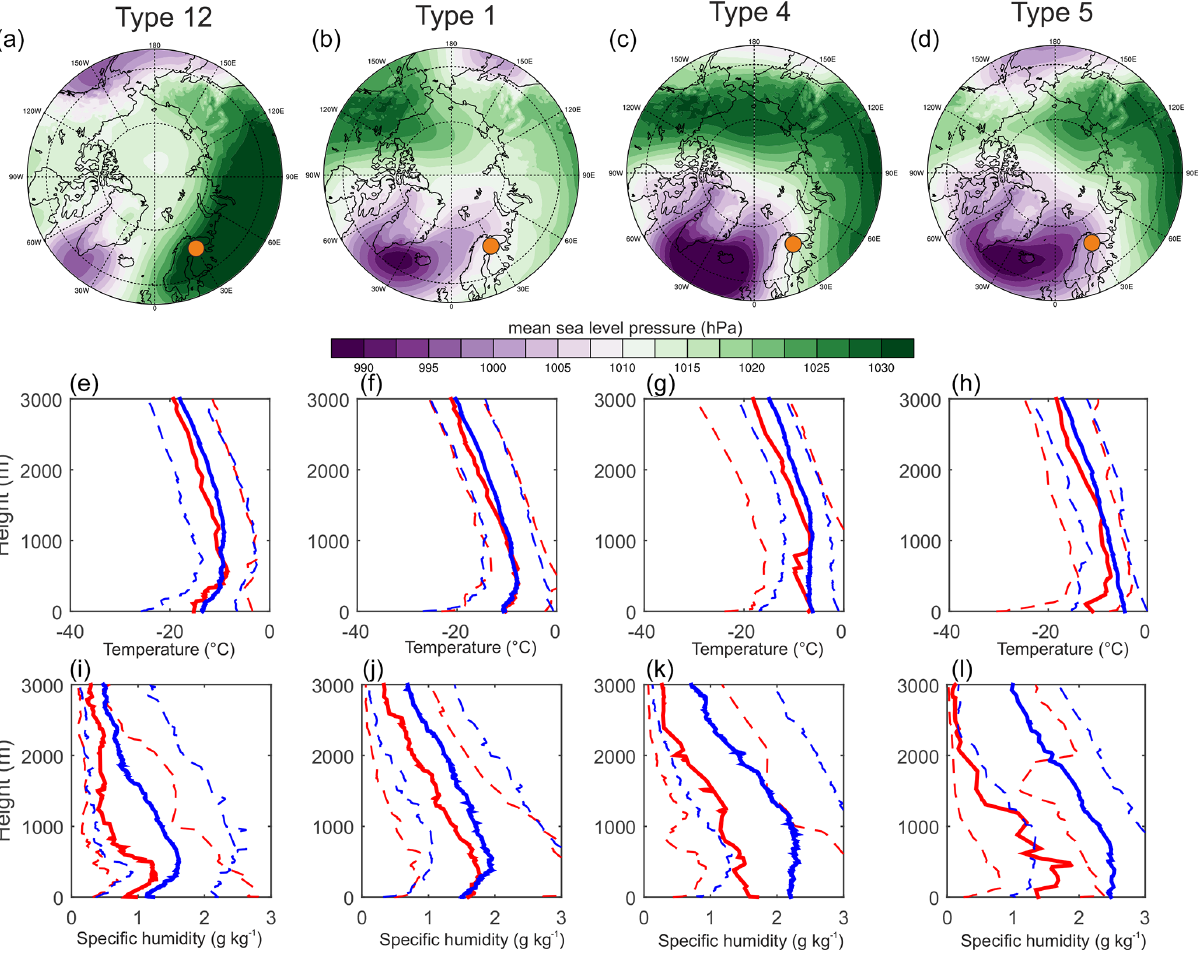
Figure 9. Median (solid lines), 10% percentile (dashed line), 90% percentile (dashed line) of temperature profiles (e–h) and specific humidity profiles (i–l) at Sodankylä for four atmospheric circulation types (a–d) in winter during 2009–2018. The profiles are based on radiosounding observations. Red lines show radiatively clear profiles, blue lines radiatively cloudy profiles. The location of Sodankylä is marked with a circle in (a) – (d)